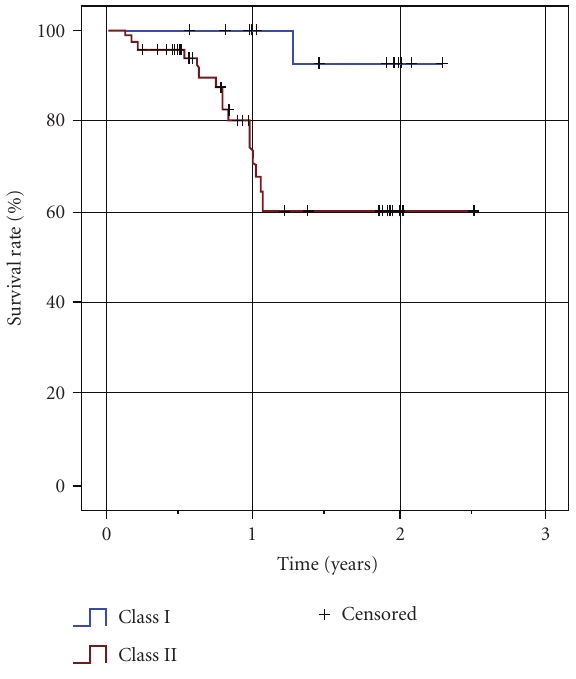
Figure 1: Kaplan-Meier survival